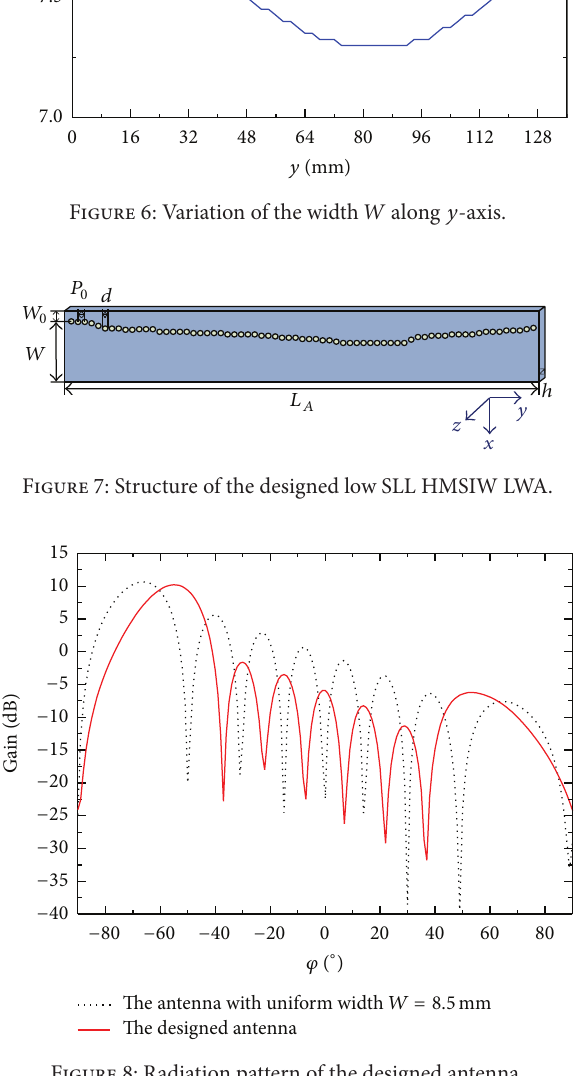
Figure 8: Radiation pattern of the designed antenna.